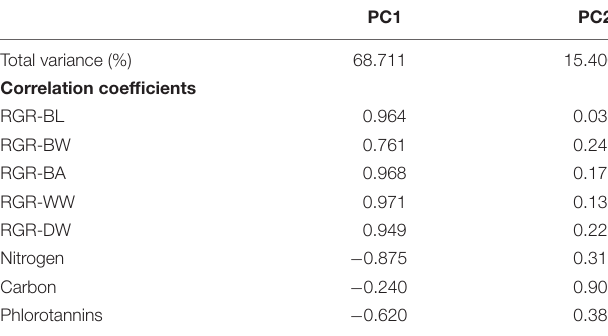
TABLE 2 | Percentage of total variance and correlations of two principal components of E. bicyclis juvenile sporophytes cultured at two different temperatures.